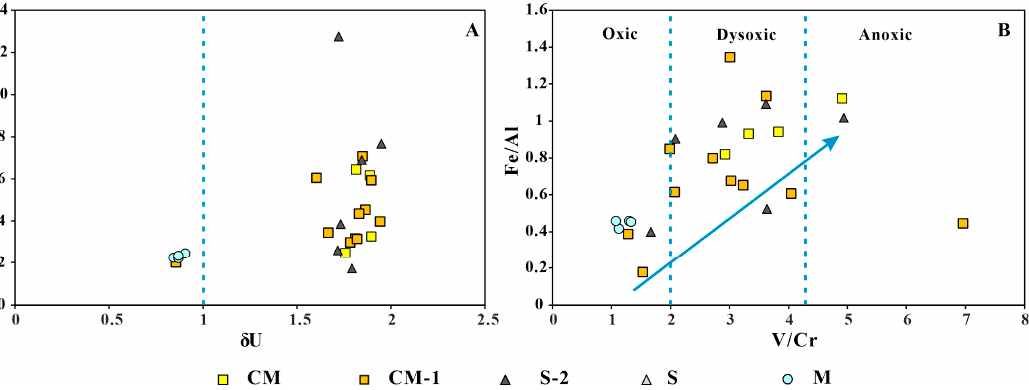
Figure 8. ( A ) Crossplots of δ U versus Ni/Co contents. ( B ) Crossplots of V/Cr versus Fe/Al contents for redox conditions of the Chang 7 Member in the Ordos Basin.